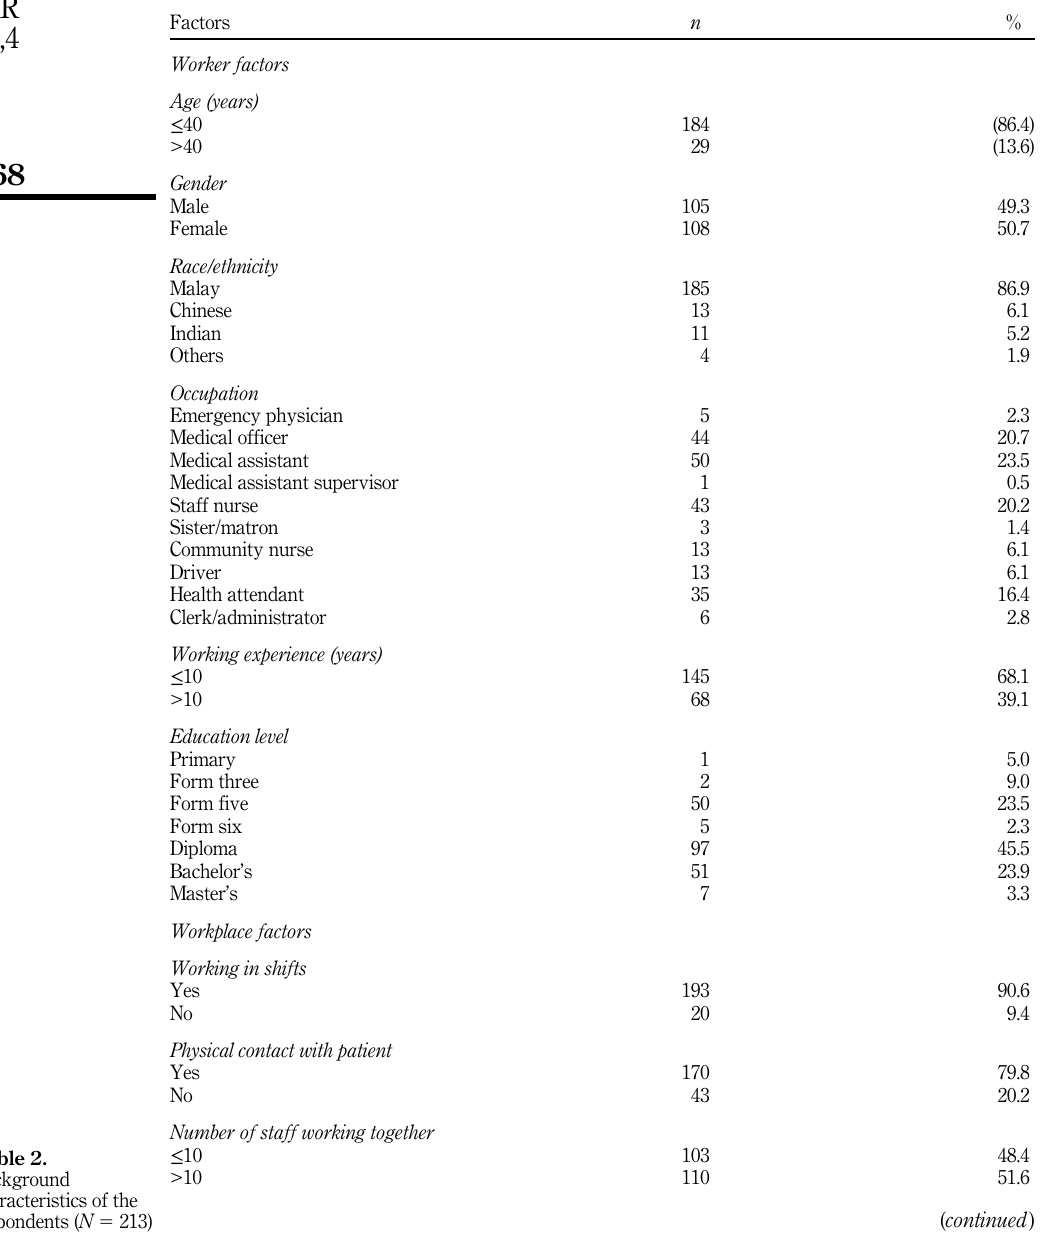
characteristics of the respondents ( N 5